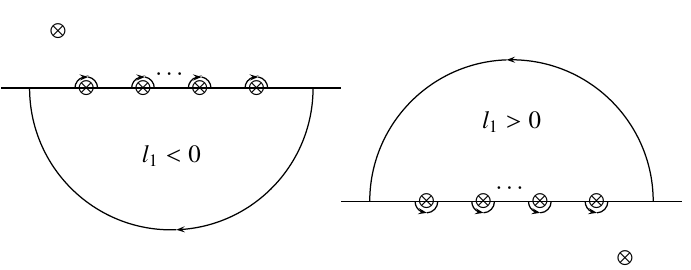
Figure 2. We close the contour integration for l 0 that the poles in (22) locate outside the contour.